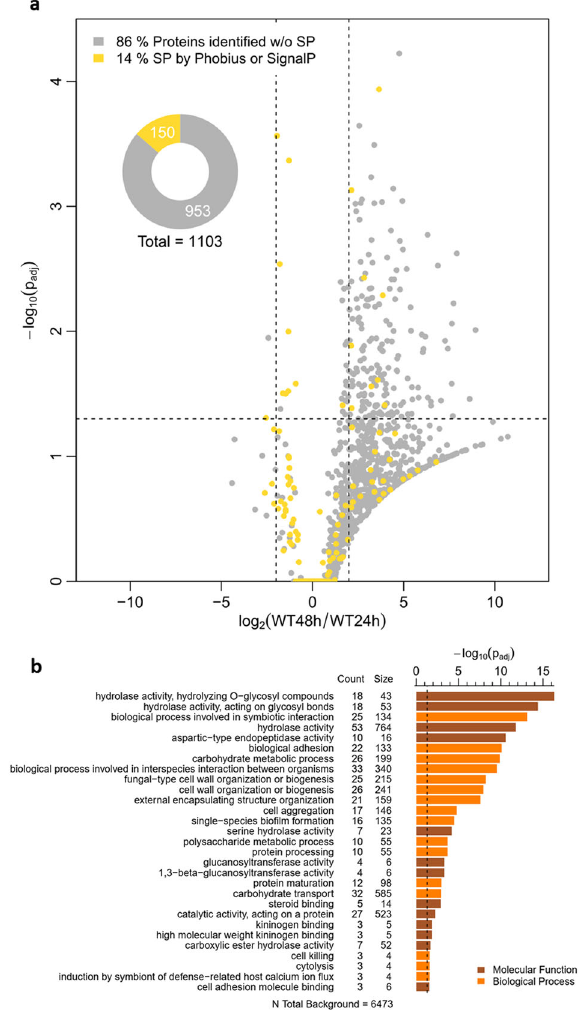
Fig. 3 Secretome analysis of mature C. albicans bio fi lm media. a Volcano plot illustrating the log 2 ratio of secreted proteins in 48 and 24 h bio fi lms to the corresponding p adj value ( − log 10 ). Dashed lines symbolize the cutoff ( p < 0.05 and log 2 FC ± 2). A total of 1103 different proteins were identi fi ed in all bio fi lms examined, with 801 proteins detected at 24 h and 1067 proteins detected at 48 h. Only 14% contained a signal peptide (SP) for directed secretion. Both the fraction with and without SP showed higher protein quality after 48 h. b GO term analysis of all detected proteins containing an SP. Counts represent observed protein abundance compared to the number of proteins assigned to the term (size). Results for molecular function and biological process were each summarized using REVIGO with a cutoff of 0.5 dispensability. Source data are provided as a Source Data fi